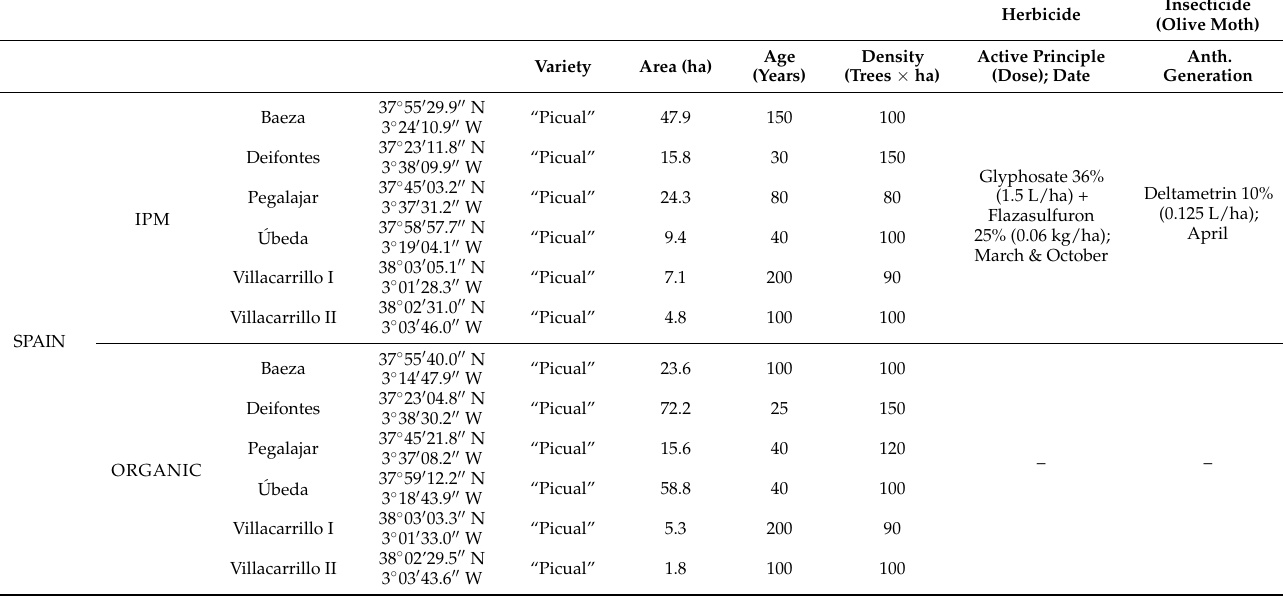
Table 2. Geographical location of the olive groves (IPM and organic management) considered in the south of Portugal. The main characteristics of each of them (variety, area, age of the trees, plantation density), and the chemical control measures applied to control the herbaceous plant cover, as well as against the anthophagous/carpophagous generations of P. oleae, are indicated. An asterisk (*) indicates organic–biodynamic crops.